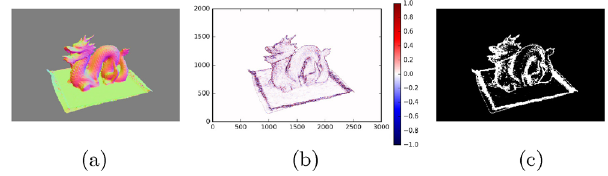
Fig. 6 (a) Reconstructed surface normal map. (b) Acquired curvature. (c) Mask using the